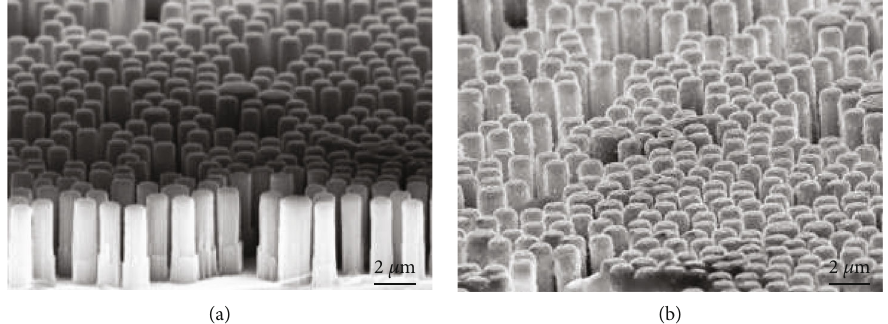
Figure 10: SEM 20 ° tilt images of a-Si:H/c-Si vertical-aligned tandem test structure before (a) and after (b) top ITO layer deposition.